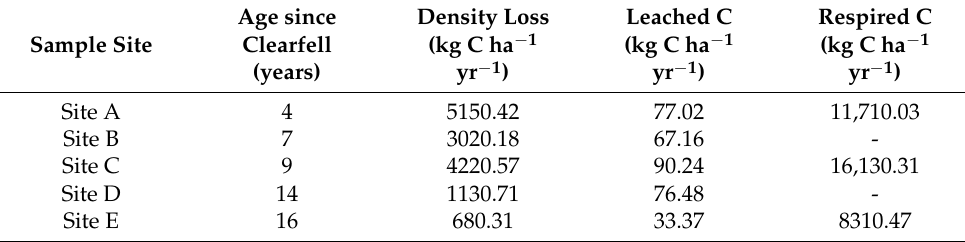
Table 5. Annual windrow carbon losses estimated from changes in WD density over time (this study) are compared to alternative estimates derived from two pathways, leaching and respiration (from Pastore et al. [29]). All estimates were based on measurements at the same sampling locations. C losses were calculated by scaling windrow rates to stand level, assuming that windrows covered approximately 7% of a site’s area. Respiration was not assessed at sites B and C because of practical considerations. Age Sample Site